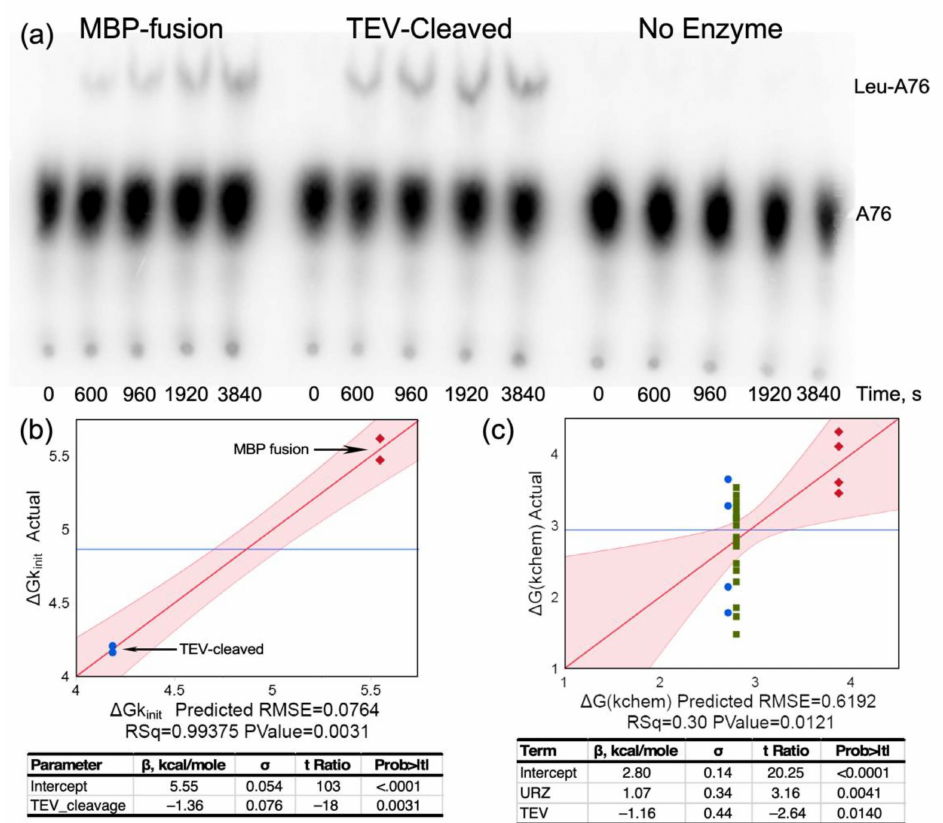
Figure 6. Aminoacylation of tRNA Leu by LeuAC increases upon TEV cleavage of the MBP fusion. ( a ) TLC of time courses for the MBP fusion, TEV-cleaved LeuAC, and a minus enzyme control. ( b ) Comparison of the initial rates for matched assays similar to that in A on different days, with the corresponding regression analysis indicating a decrease of –1.36 in ∆ G ‡ for the initial rate, corresponding to an ~10-fold increase in rate. ( c ) A similar regression analysis of the dependence of the first-order rate, ∆ G ‡ k chem , obtained from biphasic kinetic parameters for fitting time courses for the 28 acylation experiments in Supplementary Table S2. In ( b , c ), red diamonds are MBP fusion, blue circles are TEV-cleaved LeuAC, and in ( c ) green squares are full-length